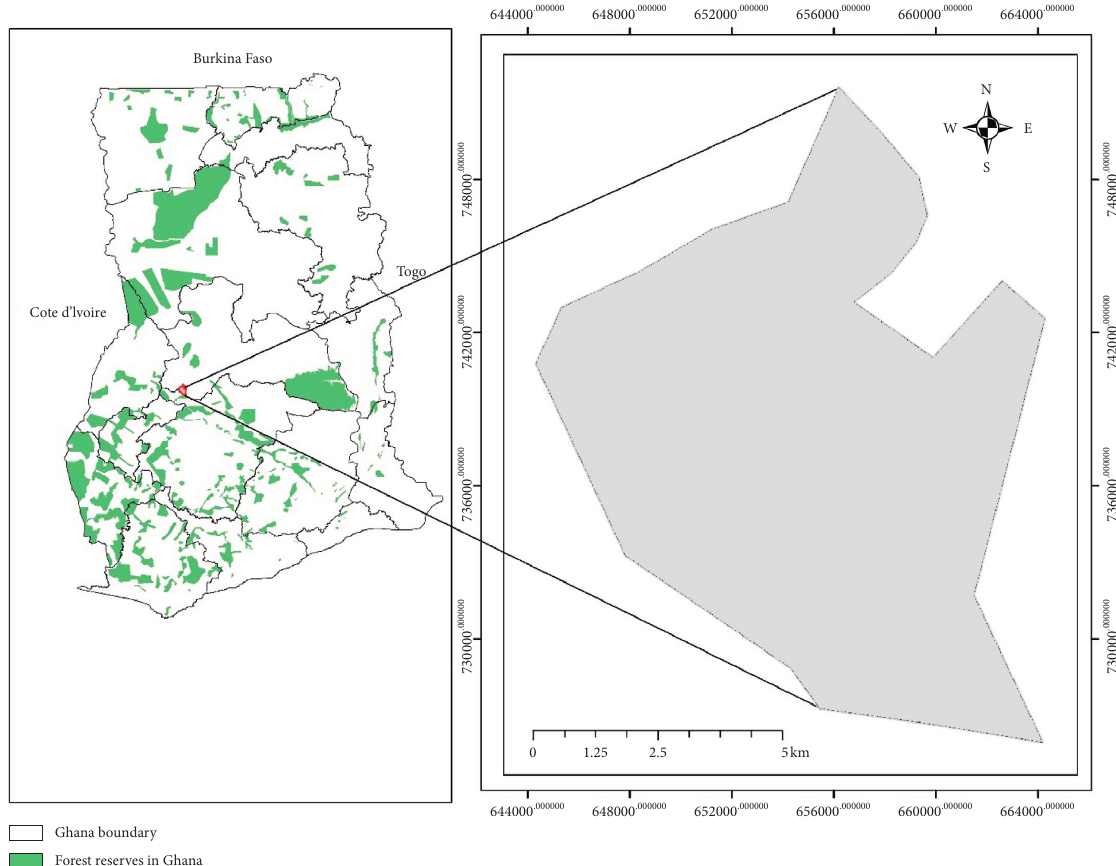
Figure 1: Map of Ghana showing the study